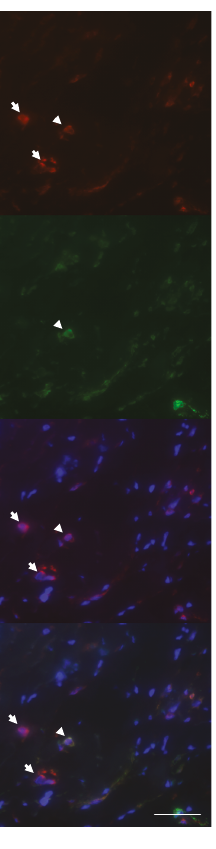
Figure 7: Double-labelling of PAI-1 (red) and CD45 (green) in an irradiated vein. Arrowheads indicate colocalization of PAI-1 and CD45, indicating expression of PAI-1 in leukocytes. Arrows indicate cells with PAI-1 expression but no CD45 expression. Nuclear stain (DAPI) is shown in blue (scale bar =50 μ